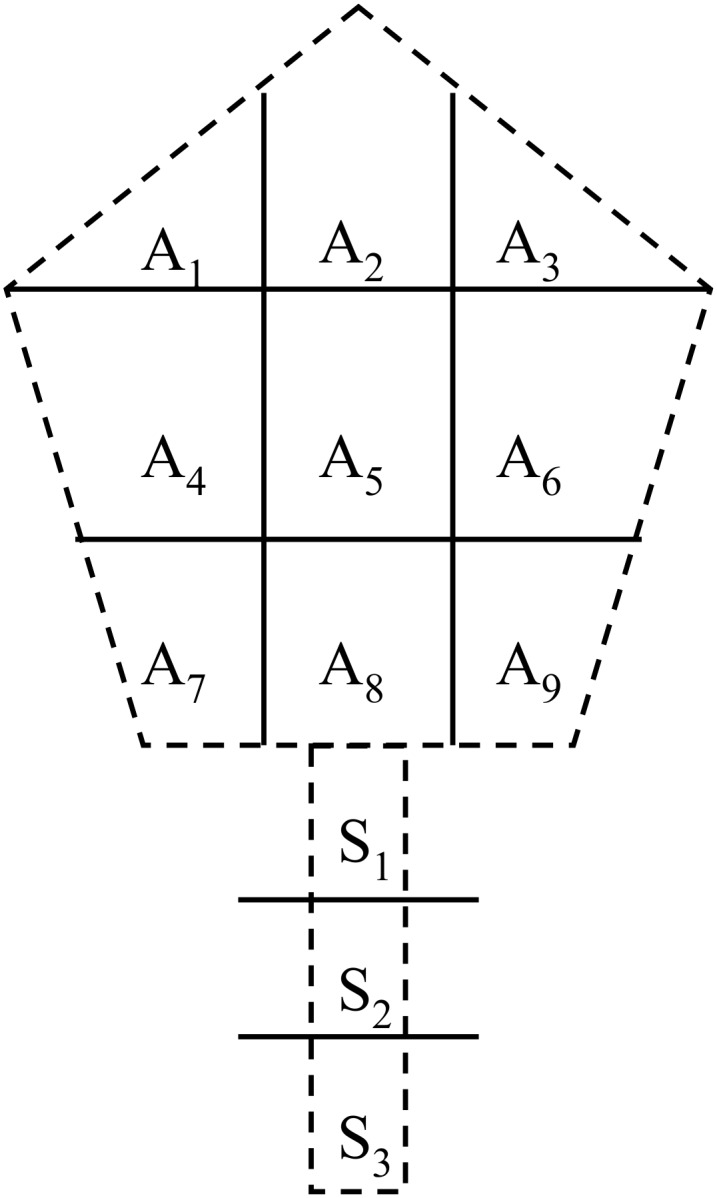
Diagrammatic of the selecting method about sub-samples of apple tree.